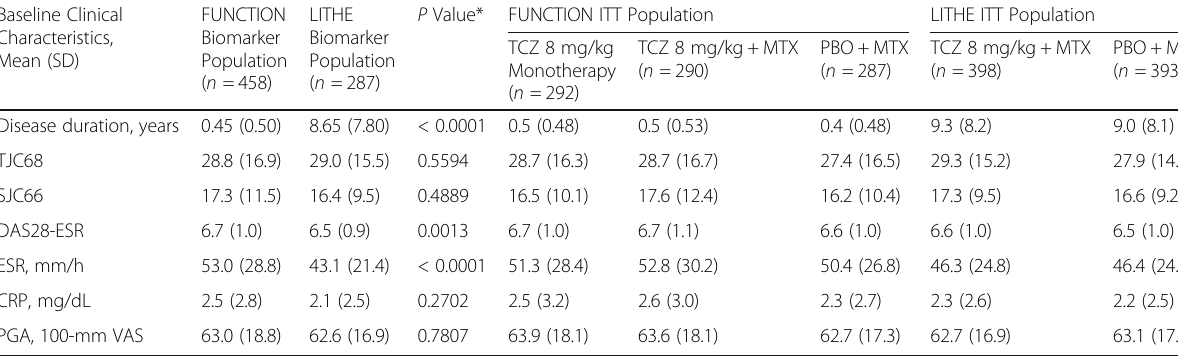
Table 1 Baseline Clinical Characteristics Baseline Clinical